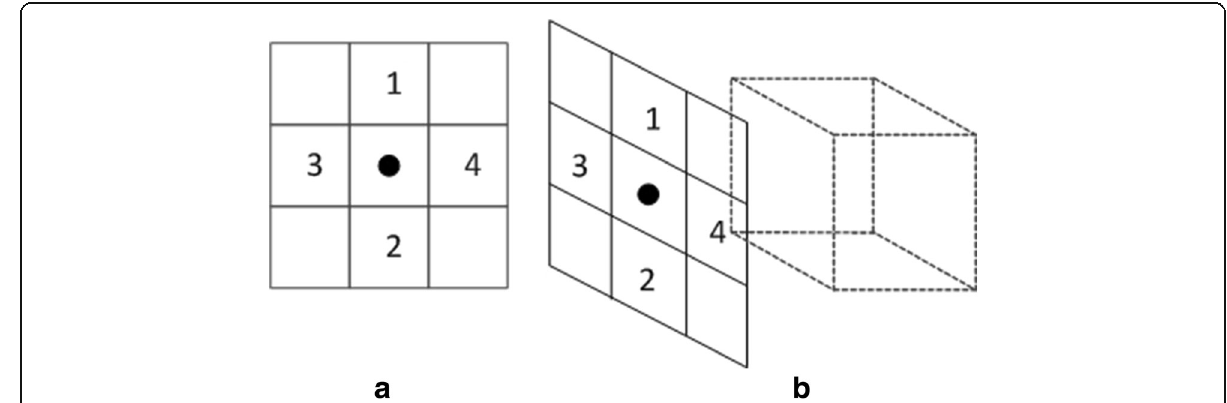
Fig. 4 The reconstruction of normal. a Centre point. b Local bounding